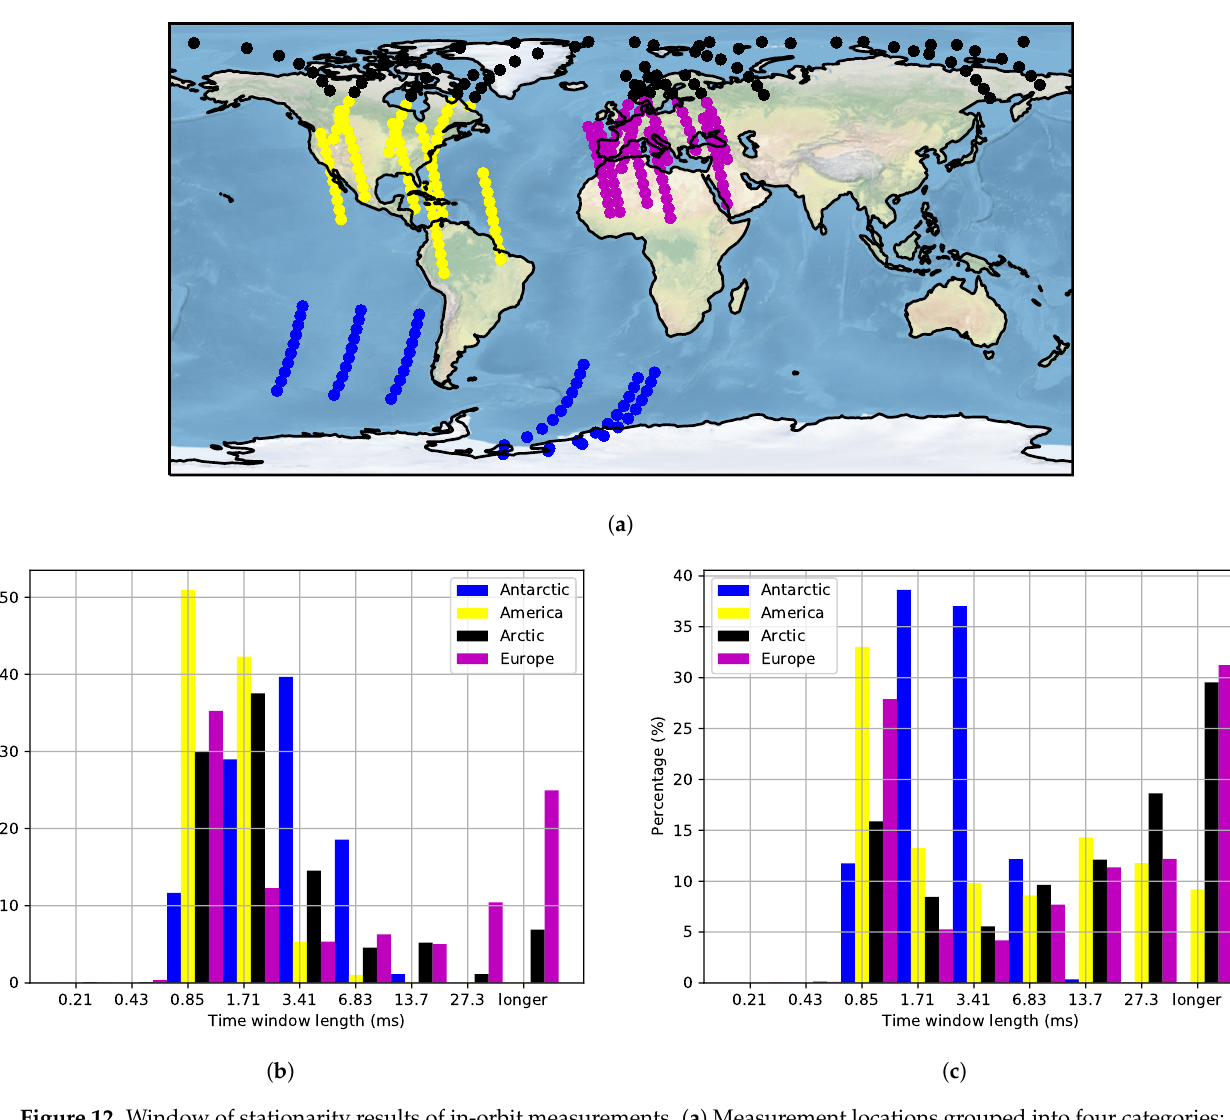
Figure 12. Window of stationarity results of in-orbit measurements. ( a ) Measurement locations grouped into four categories: Antarctic (blue), America (yellow), Arctic (black), and Europe (magenta). ( b ) Histogram of stationarity window per region (outside band-limited interference bandwidth). ( c ) Histogram of stationarity window per region (within band-limited interference